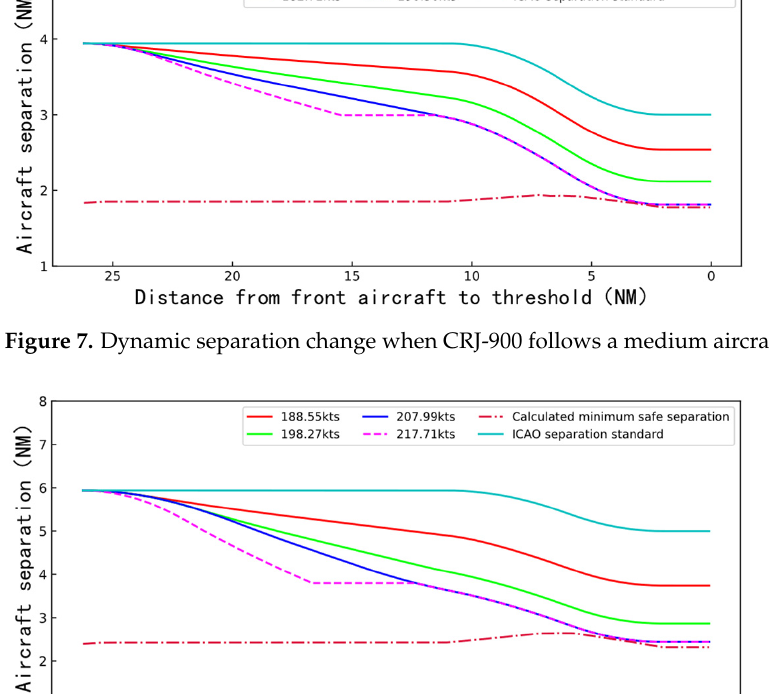
Figure 6. The front and following aircraft velocity profiles.